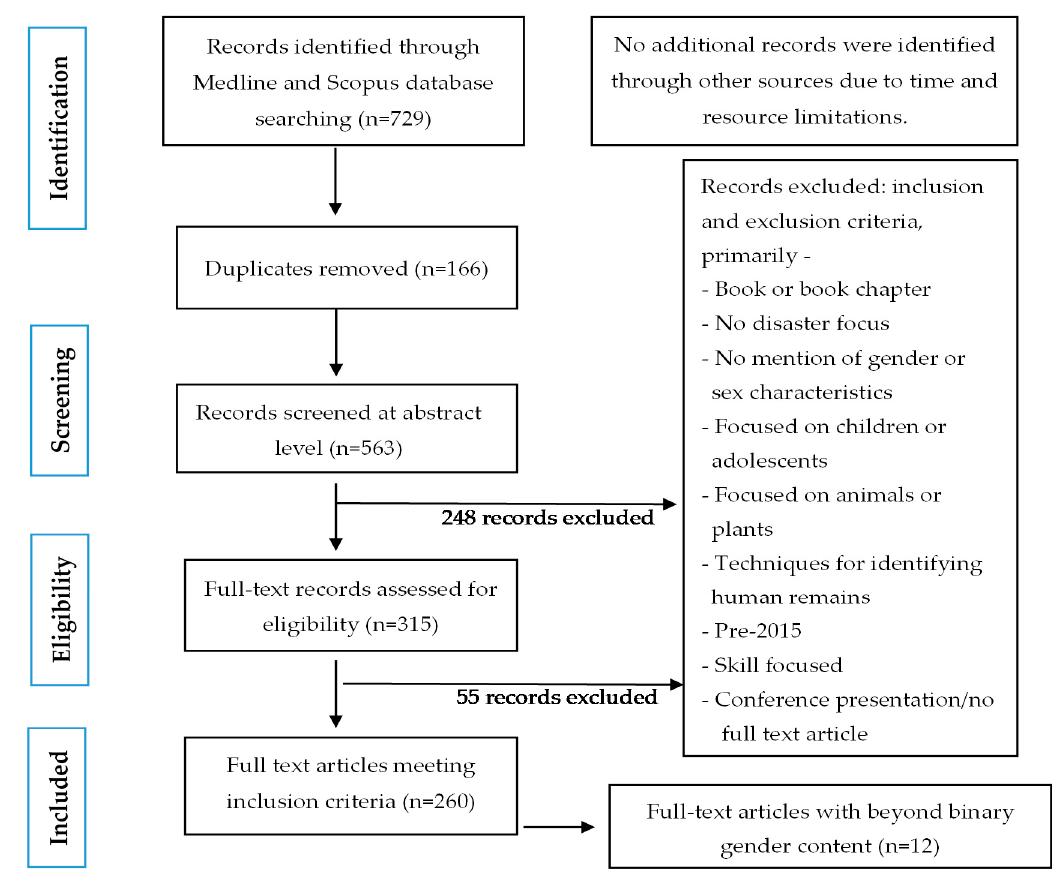
Figure 1. Preferred reporting items for systematic reviews and meta-analysis (PRISMA) flow diagram for rapid review article selection. Table 2. Rapid review: papers referring to minority genders outside of the binary ( n = 12). Citation